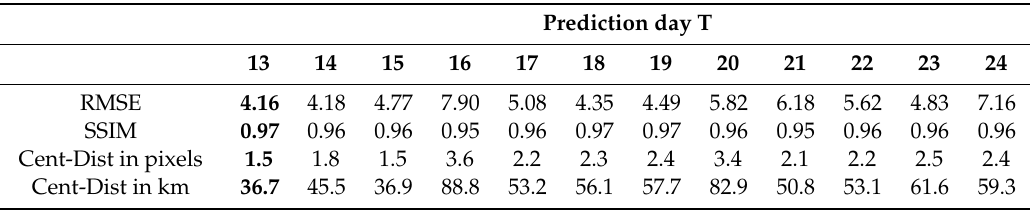
Table 14. Daily comparison of RMSE, SSIM, and centroid distance of case